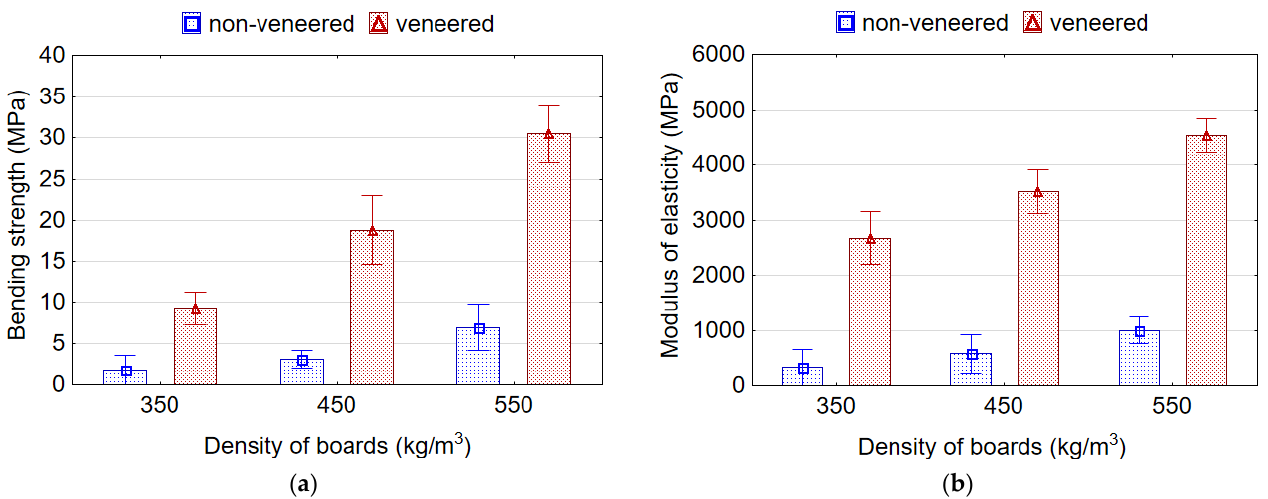
Figure 9. Bending strength ( a ) and modulus of elasticity ( b ) of non-veneered and veneered lightweight particleboards.